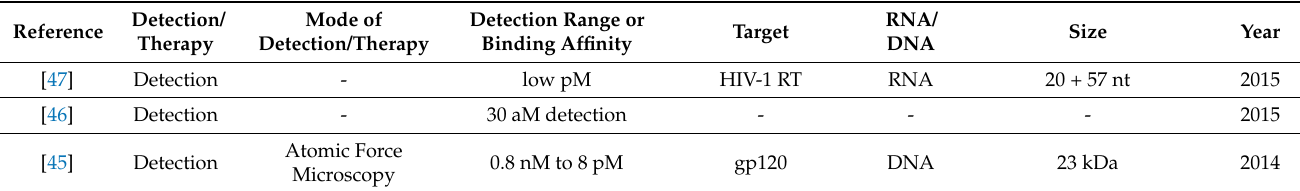
Table A1. List of aptamers and their properties for treatment and detection of HIV.